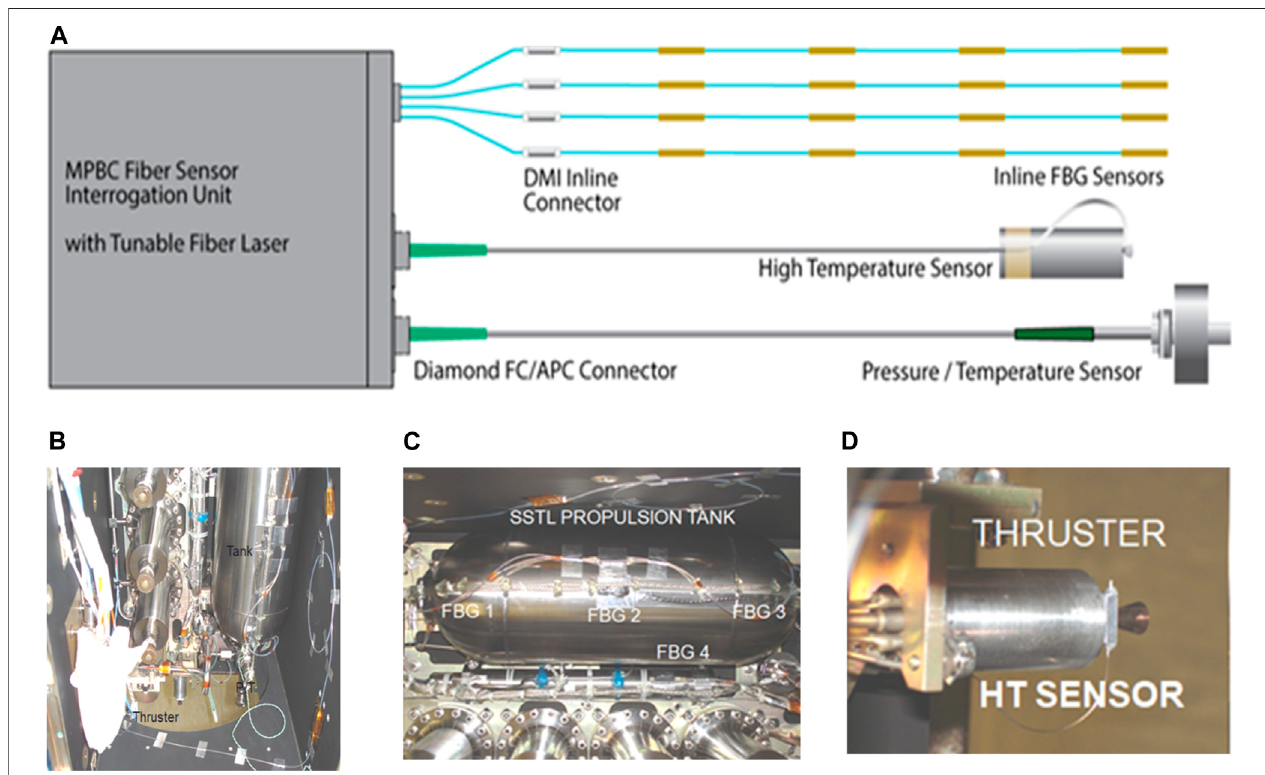
FIGURE 14 | (A) Block diagram of the Fiber-optic Sensor Demonstrator for Proba-2, (B – D) Pictures of Fiber Sensors Installed on Proba-2.